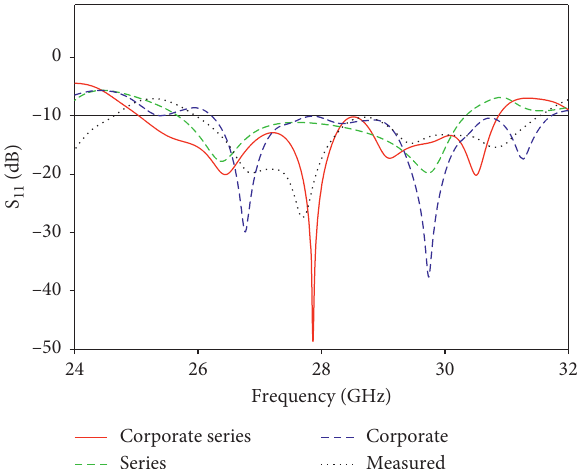
Figure 12: Measured and simulated S 11 of proposed corporate-series-fed microstrip array antenna versus S 11 of array antenna with series- and corporate- feed.